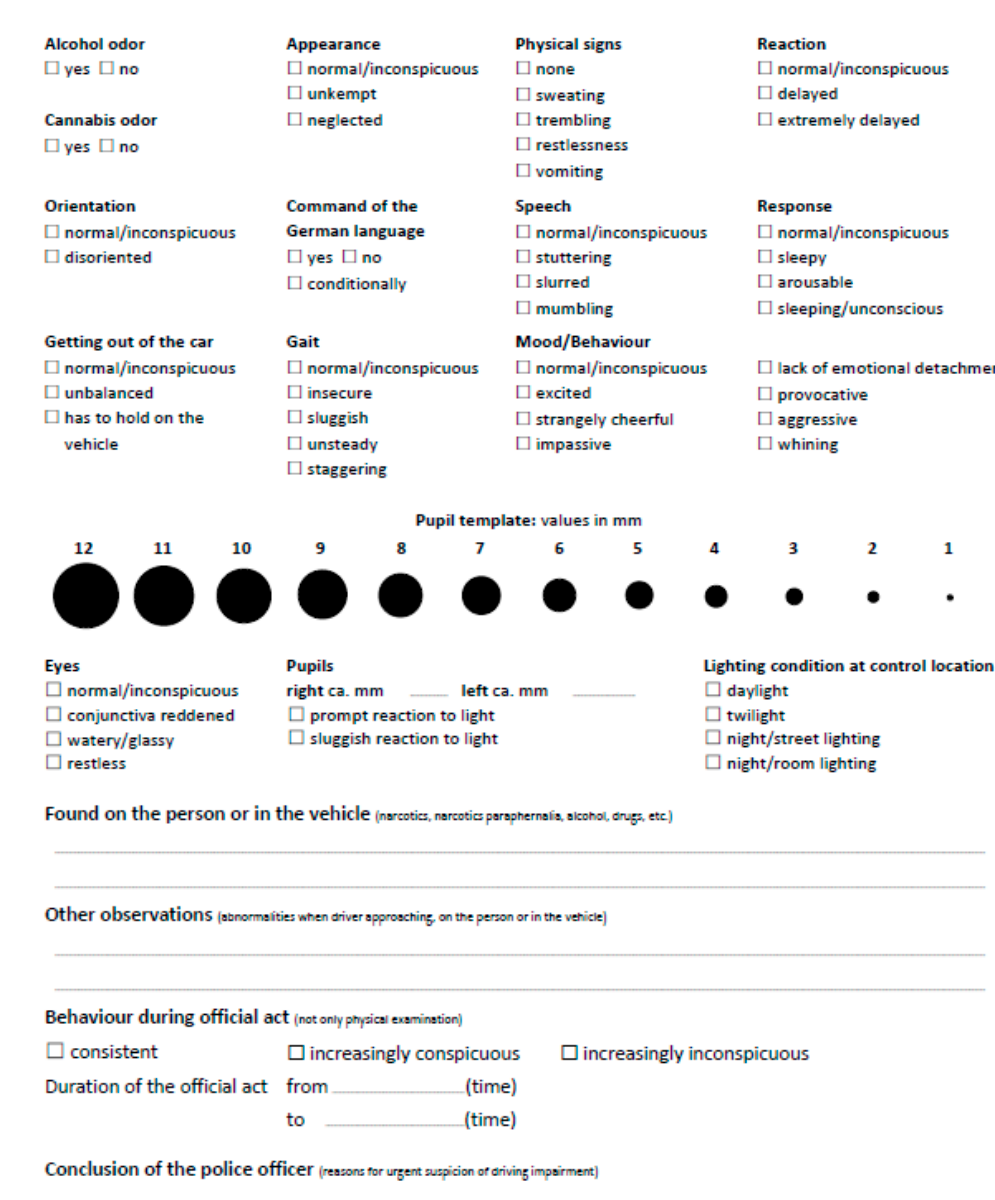
Figure 1. The VERIFY checklist consists of several items, which can be ticked if police officer thinks they apply to driver, and several open-ended questions. The VERIFY checklist is originally in